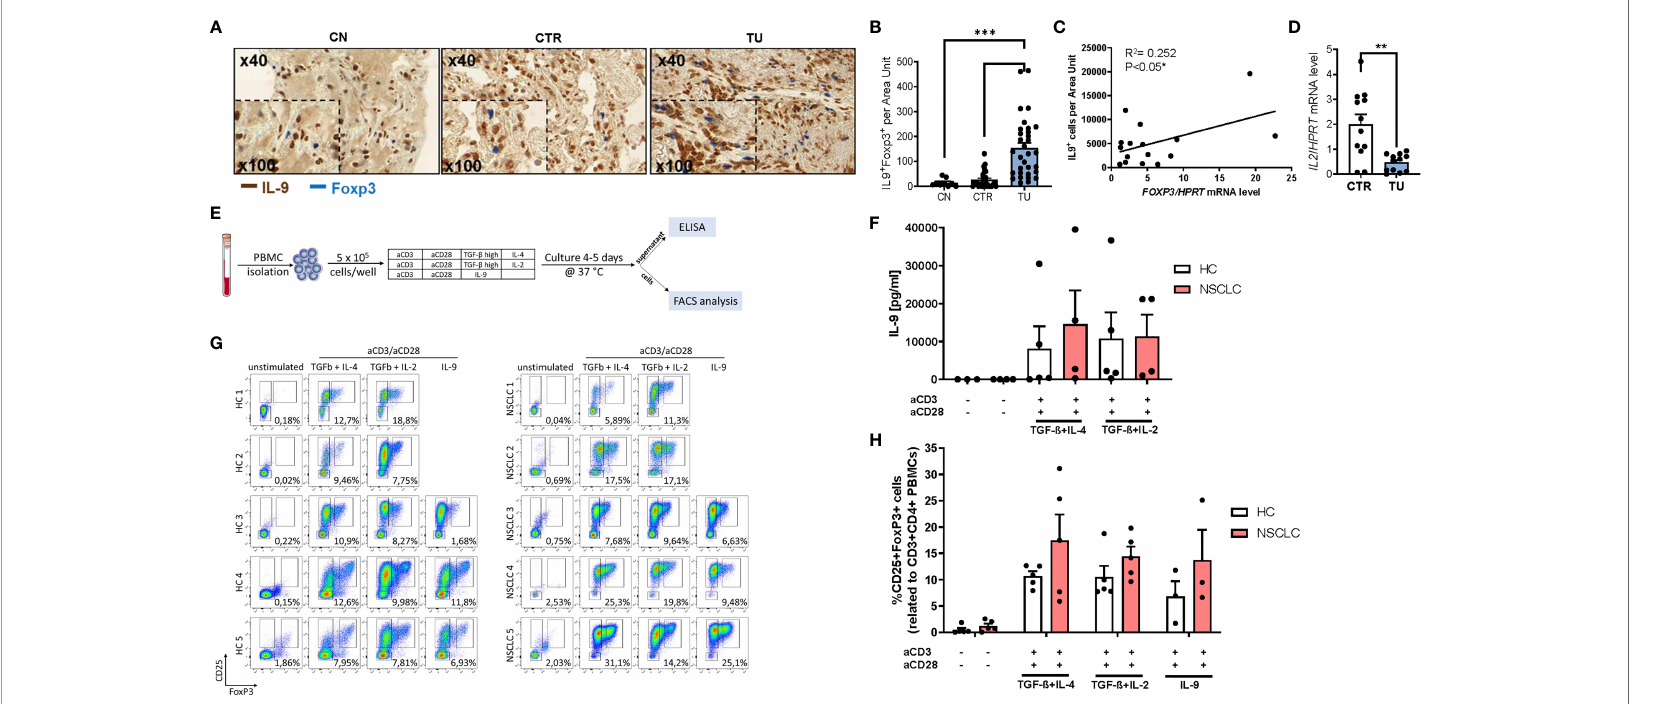
FIGURE 2 | Increased IL-9 production by regulatory T cells (Tregs) of patients with NSCLC. (A) Immunohistochemistry staining of lung tissue sections for IL-9 (colored in brown) and Foxp3 (colored in blue). Representative microscopy images are shown for one healthy control patient (CN) and the CTR and TU lung region from one NSCLC patient. Images were taken at a 40x magni fi cation while inserts show a magni fi cation of 100x. (B) Total IL-9 and FoxP3 double-positive cells per area are shown for CN (n=10) and NSCLC CTR (n=35) and NSCLC TU (n=34) Data are shown as mean + SEM. using student´s two-tailed t- test *P,0.05; **P,0.01; ***P,0.001. (C) Correlation of IL-9 + cells and FoxP3 mRNA levels from the tumoral region of NSCLC patients. Correlation was done with IL-9 + cells from the TU of immunohistochemistry staining analysis and FoxP3 mRNA levels of the TU from the same patient. mRNA levels were detected by RT-qPCR and set in relation to HPRT mRNA level (n=16). (D) qPCR based analysis of IL-2 mRNA levels of CTR and TU set in relation to HPRT mRNA level (nCTR=12; nTU=11). (E) Experimental design for the in vitro culture of PBMCs. PBMCs from NSCLC patients or healthy control patients were isolated and cultured with different conditions for 4-5 days at 37°C and 5% CO 2 (500.000 cells/well). After harvesting the cells, the supernatant was used to perform ELISA and the cells were analyzed by fl ow cytometry. (F) Analysis of IL-9 concentration (pg/ml) in the supernatant of PBMC cell culture from healthy controls (n=3-5) and NSCLC patients by ELISA (n=4. (G) Representative fl ow cytometry analysis of CD25 high FoxP3 + cells (%) gated on CD3 + CD4 + lymphocytes (n=5). Representative dot-plots showing CD25 and FoxP3 staining of PBMCs from control patients and NSCLC patients after cell culture with different conditions (unstimulated; IL-4 (20 ng/ ml) and TGF b (20 ng/ml); Treg: IL-2 (2 ng/ml) and TGF b (20 ng/ml); IL-9 (20 ng/ml)). (H) Quanti fi cation of CD25 high FoxP3 + Tregs (n HC =5, n NSCLC =5; IL9-condition: n HC =3, n NSCLC =3). For statistical analysis One-way ANOVA test was applied. *p <